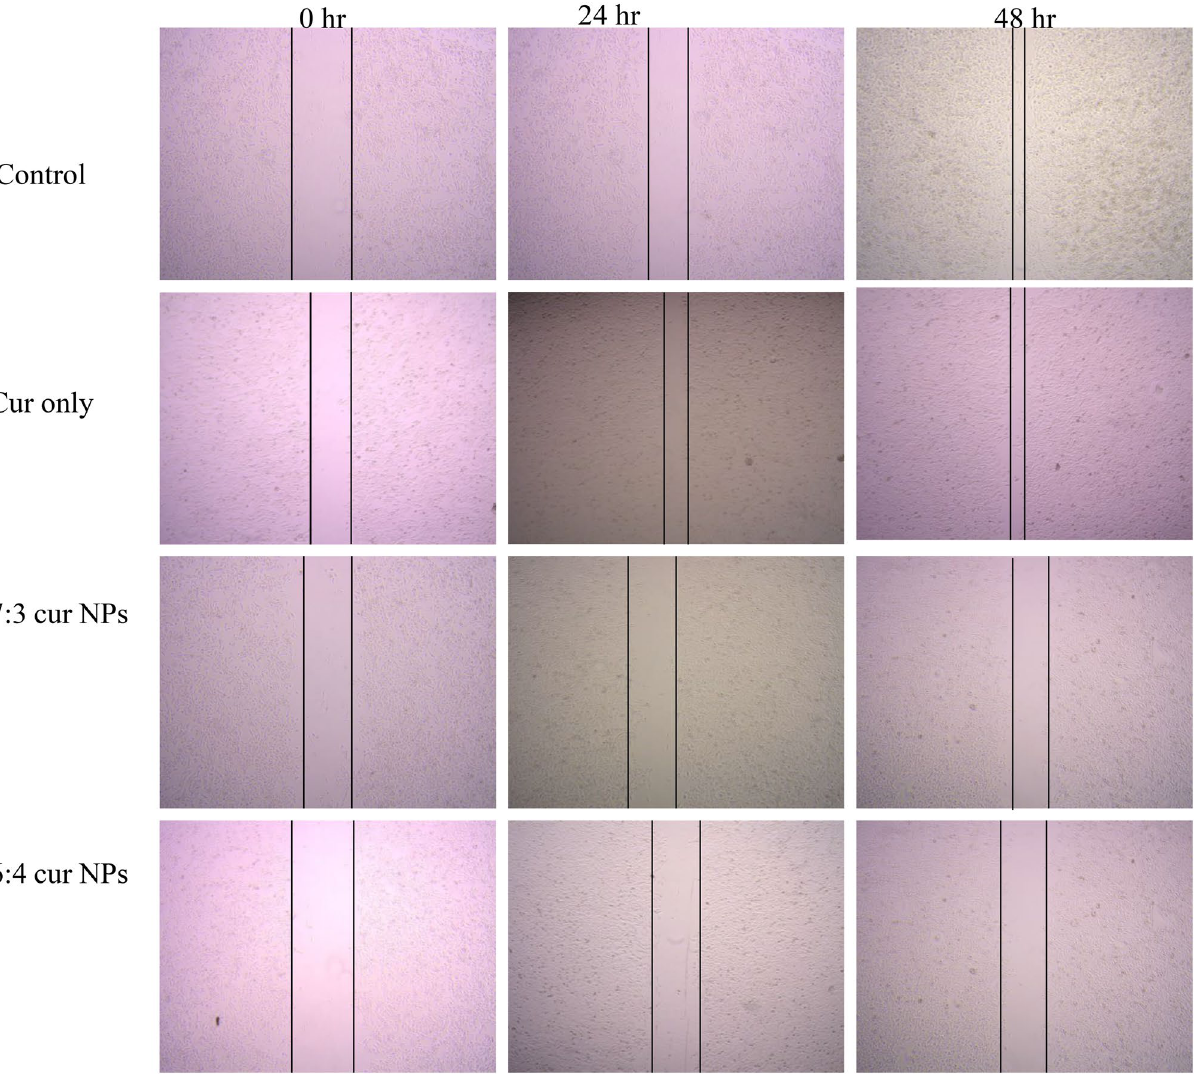
Figure 9. Microscopic images of scratch assay performed on MCF-7 cell line treated with CUR NPs and CUR